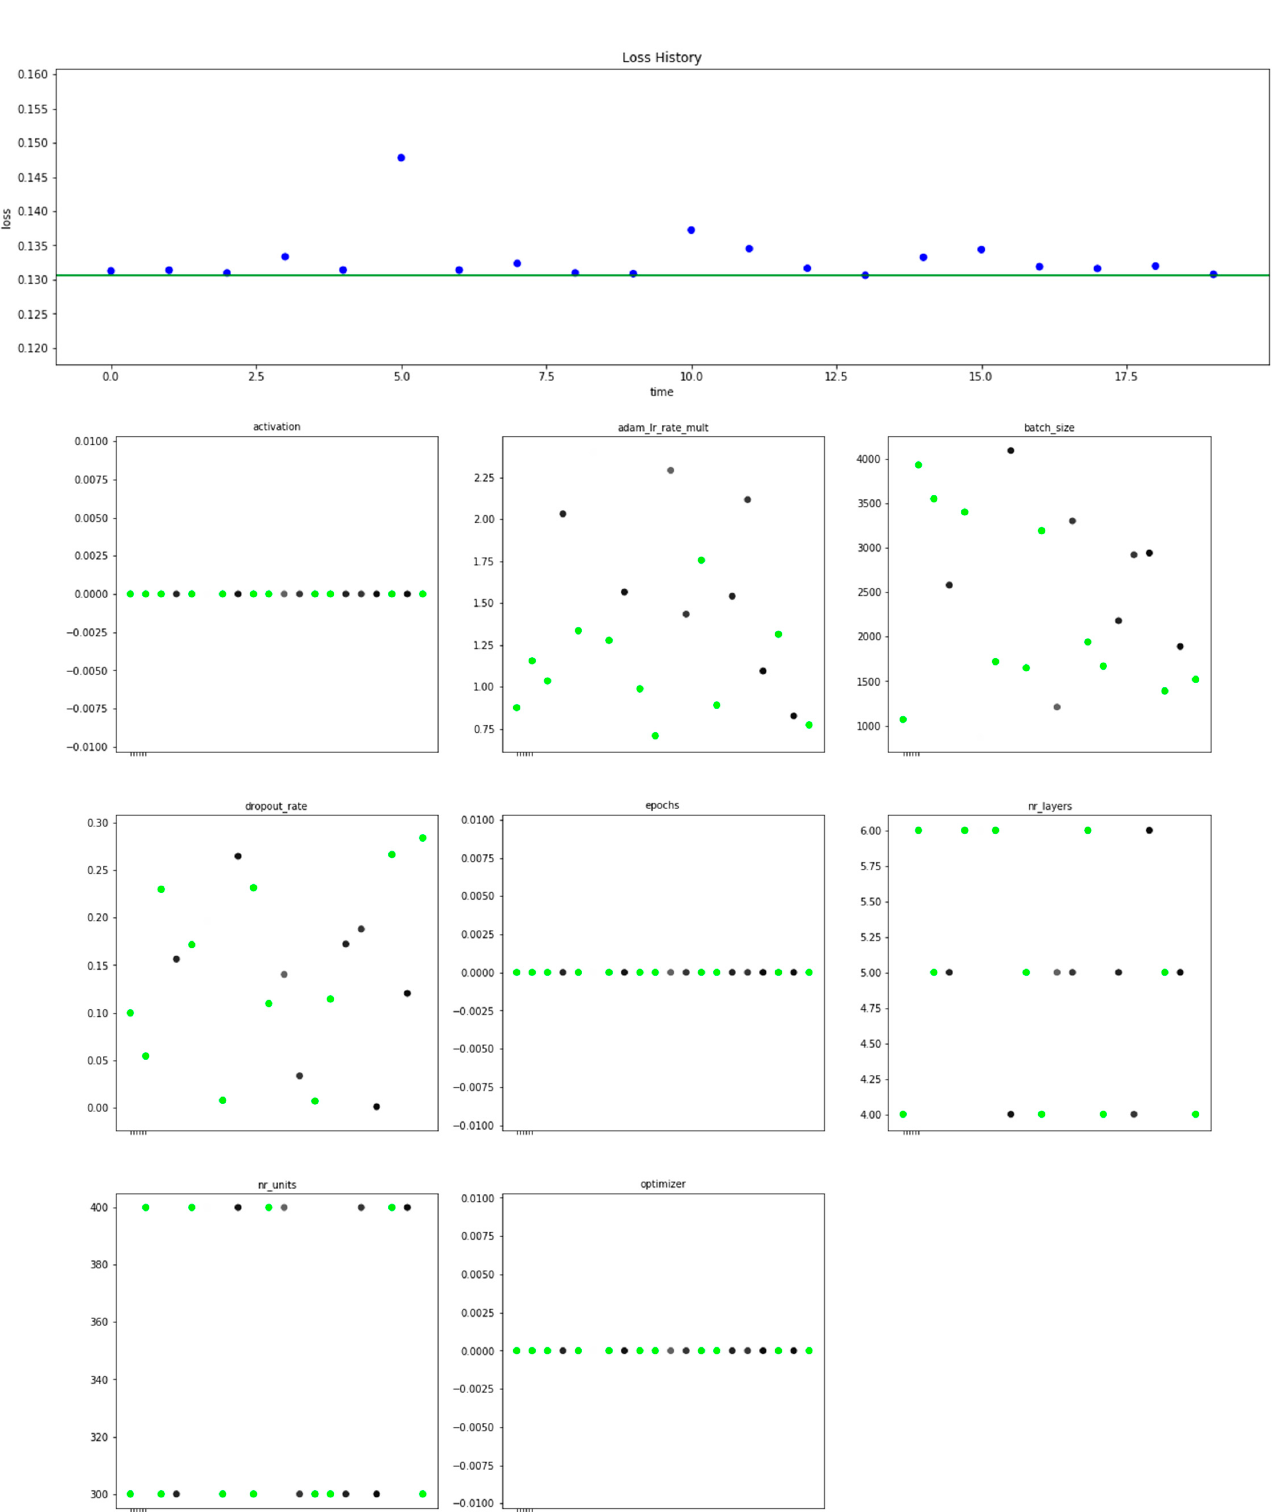
Figure 14. DNN Model Training with Hyperparameter Optimization.